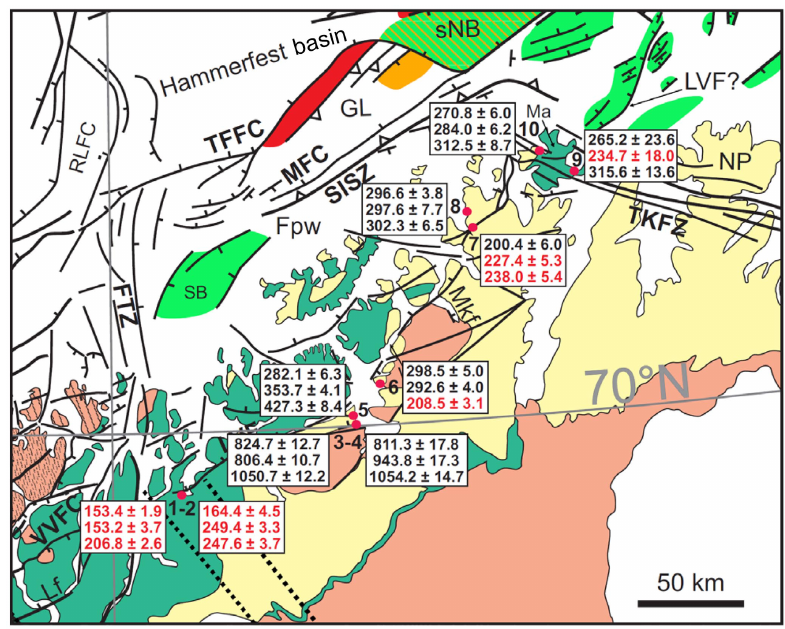
Figure 4. Structural map of the study area showing the obtained K–Ar ages for each sample in Ma, including from top to bottom finest, intermediate and coarsest grain-size fraction ages. Ages in red are considered erroneous (see main text). The map is modified after Indrevær et al. (2013) and Koehl et al. (2018a). Legend and abbreviations as are in Fig. 1.